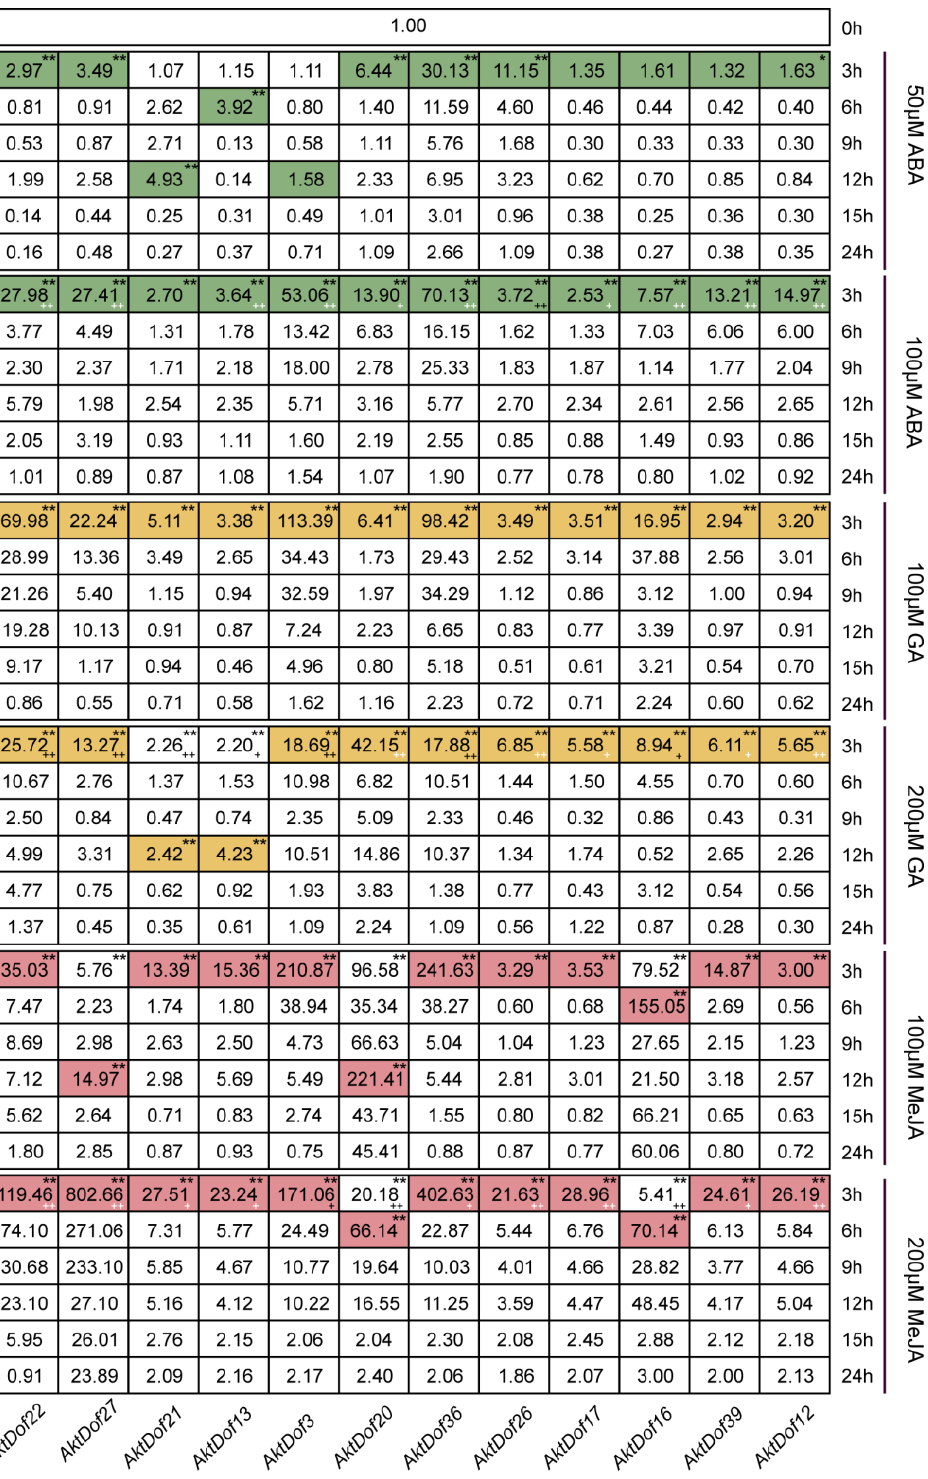
Figure 5. Expression patterns of 12 AktDofs in leaves in response to three hormone treatments. Colored undertones represent the expression peaks, and the different colors represent the different hormones. * represents the significance between both peak expression and the expression at 3 h and 0 h (*, p < 0.05; **, p < 0.01), + represents the significance between two concentrations of each hormone, +(white) indicated high-concentration hormone expression is significantly higher than low-concentration hormone expression while +(black) is the opposite, (+, p < 0.05; ++, p < 0.01).